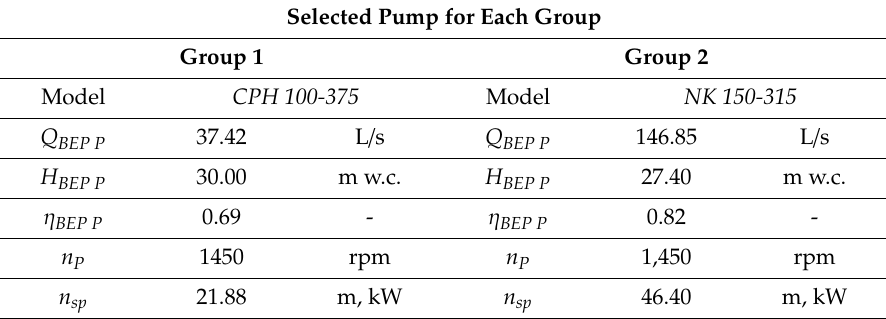
Table 12. Selected pumps and best e ffi ciency point data for each group (point